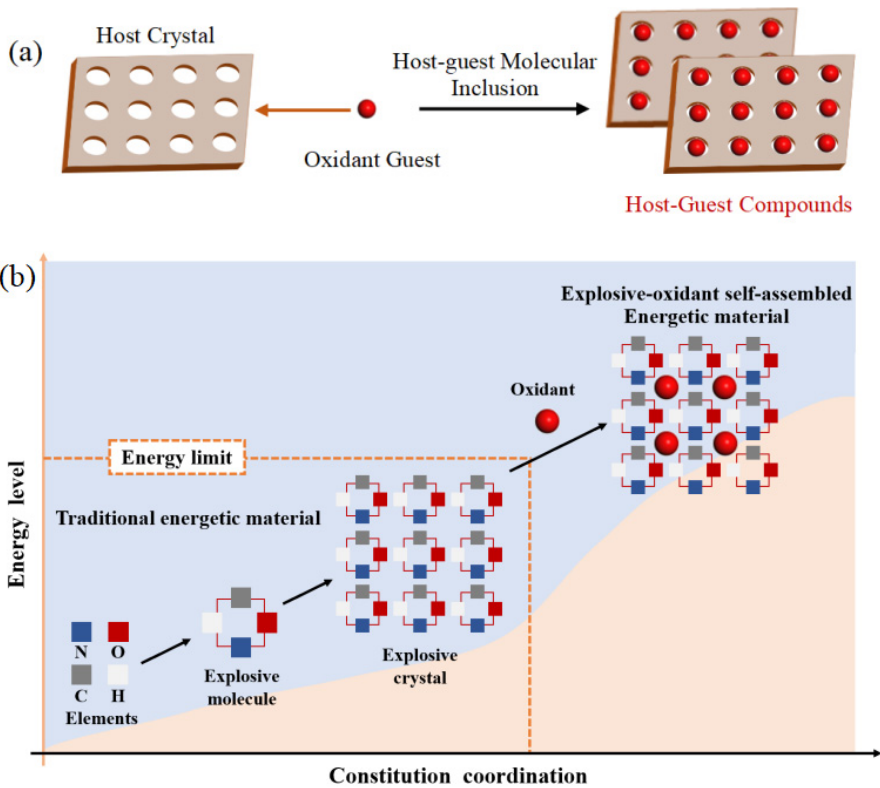
Figure 1. ( a ) 3D energetic host-guest inclusion materials [1]. ( b ) Illustration of explosive-oxidant self-assembled strategy and its comparison with traditional energetic material